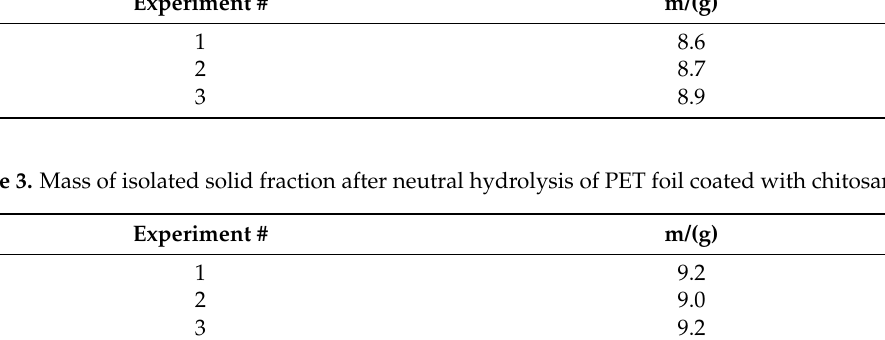
Table 2. Mass of isolated solid fraction after neutral hydrolysis of PET foil.